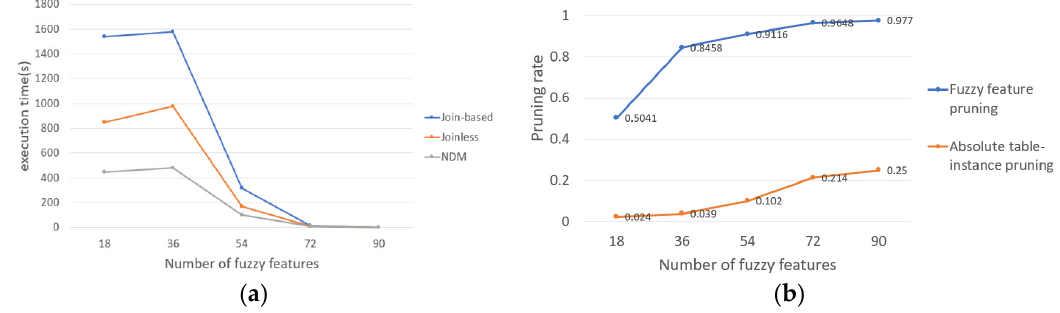
Figure 12. ( a ) Effect of the number of features; ( b ) Pruning degree of the two strategies.